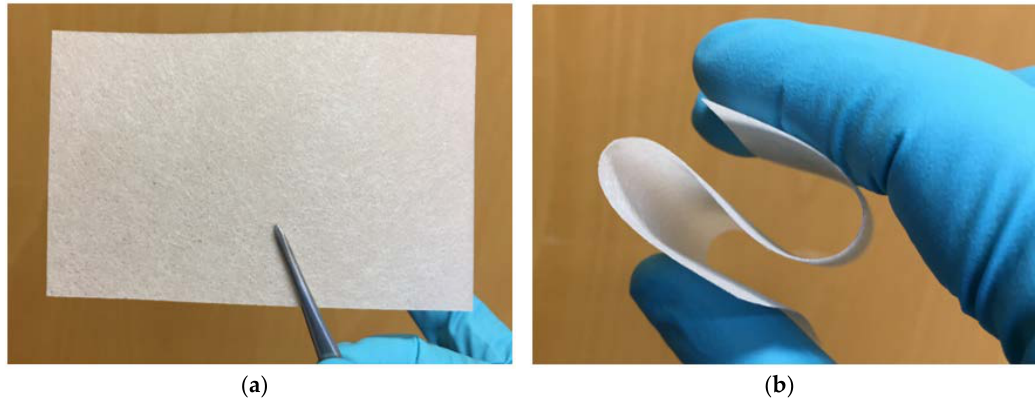
Figure 3. Pictures of a glass fiber nonwoven/glass platelet composite separator, ( a ) top view; ( b ) demonstration of the separators flexibility.